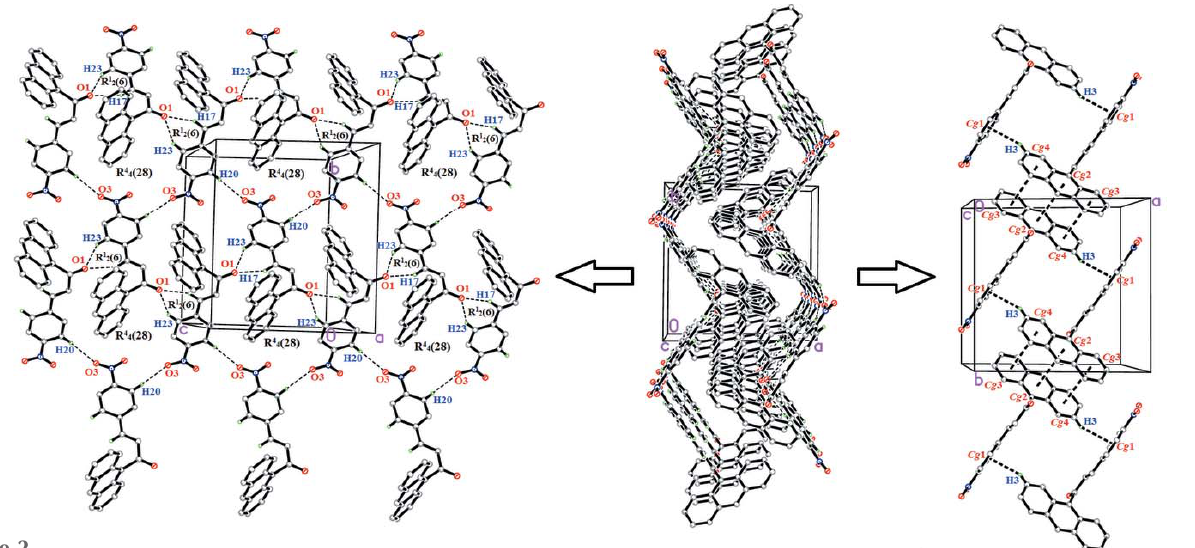
Figure 2 Packing diagram showing weak C—H (cid:4)(cid:4)(cid:4) O, C—H (cid:4)(cid:4)(cid:4) (cid:2) and (cid:2) – (cid:2) interactions in (I).